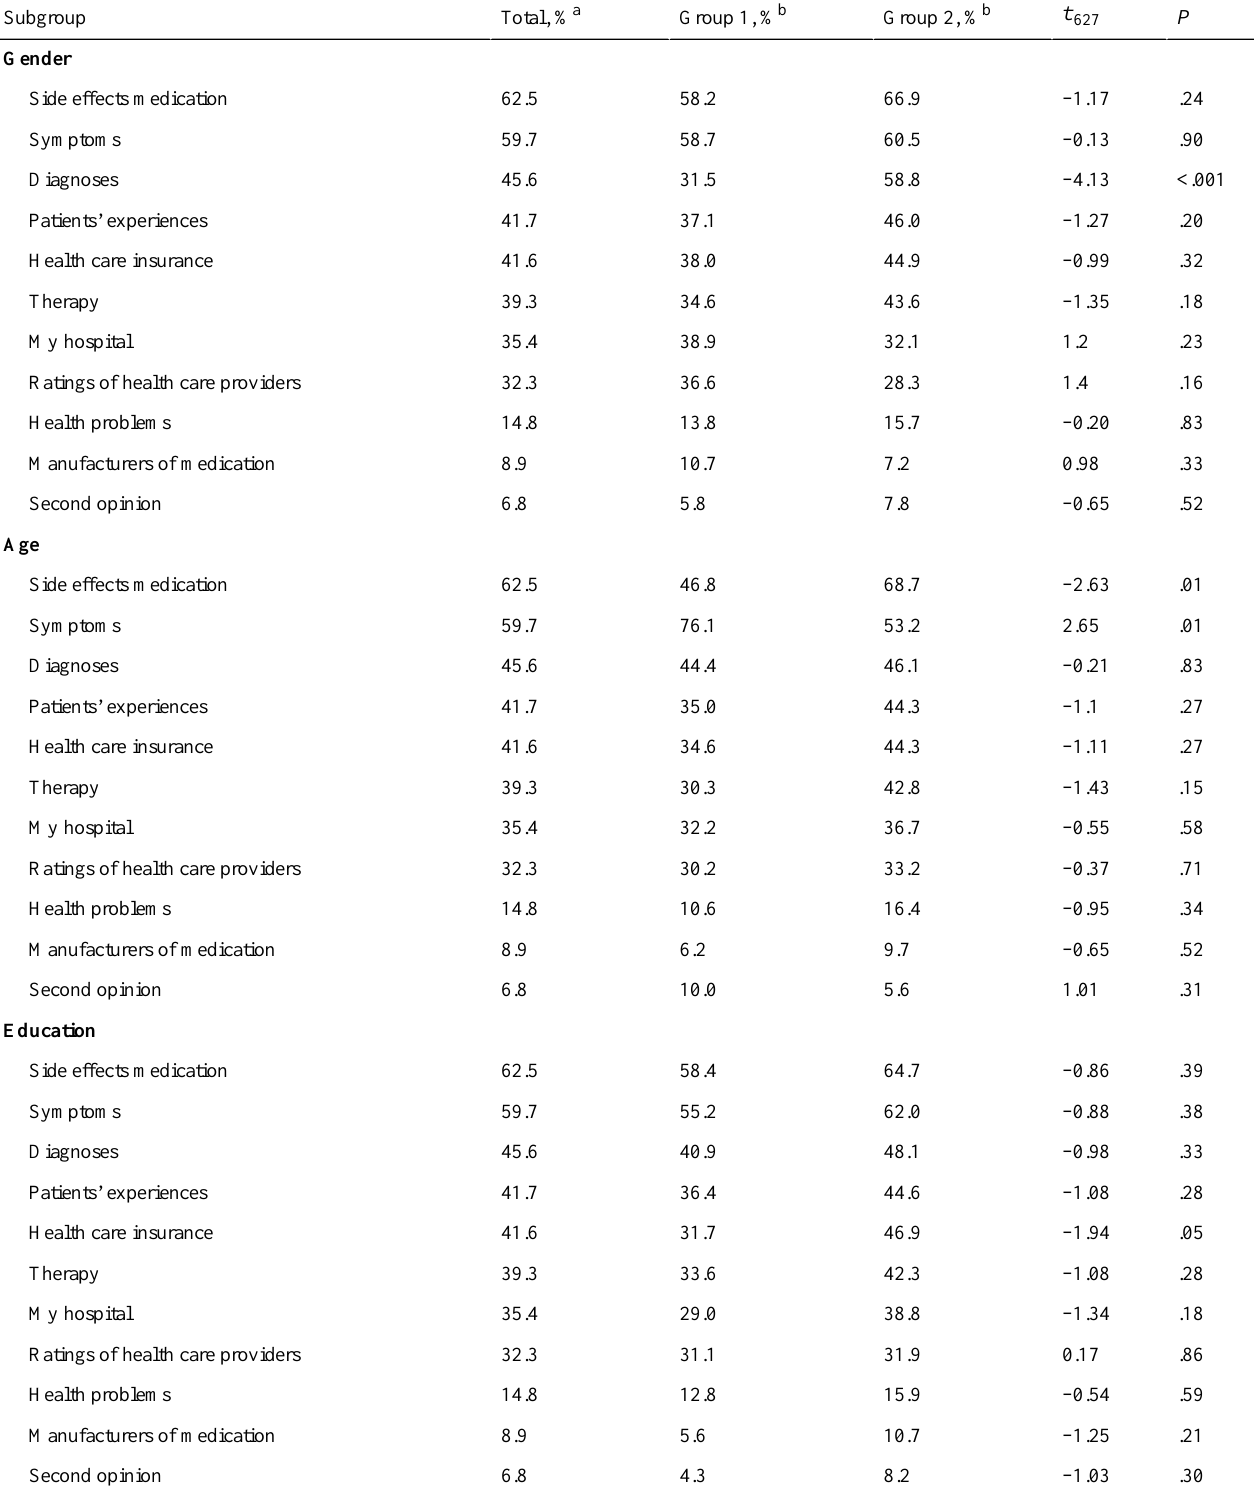
Table 3. Type of health-related information searched for